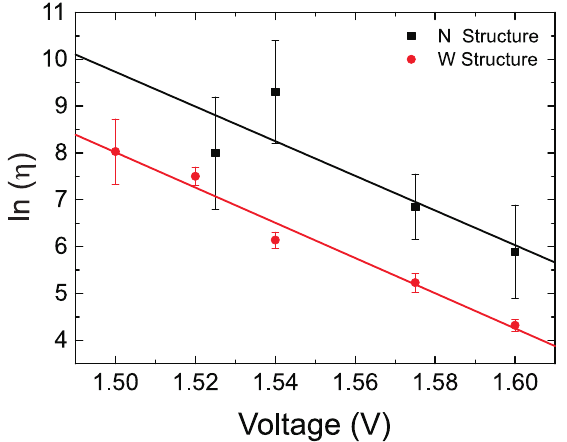
Figure 4. Dependence of the logarithm of the lifetime η on the applied voltage. The data for both alternative designs are shown separately. The lines represent a fit to the exponential law shown in Equation